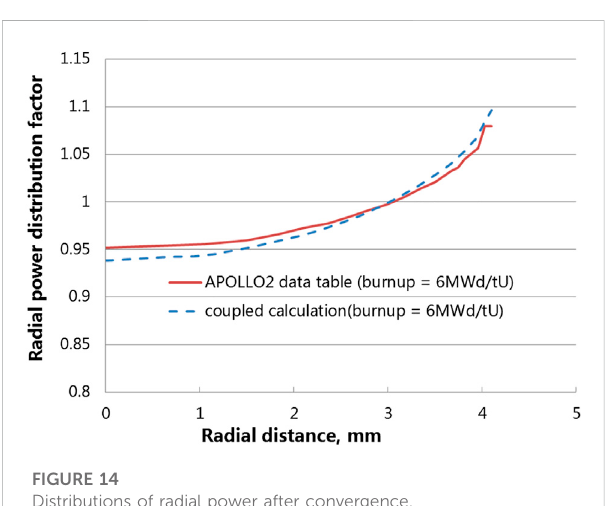
FIGURE 14 Distributions of radial power after